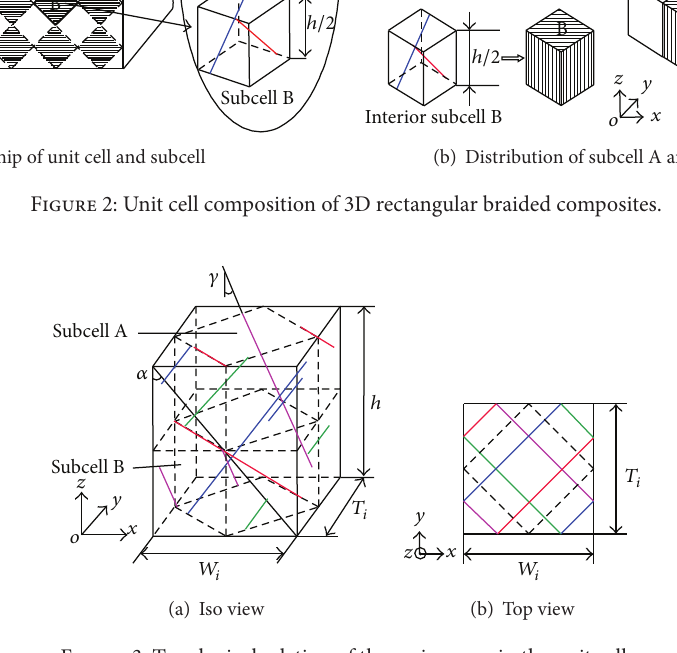
Figure 3: Topological relation of the main yarns in the unit cell.